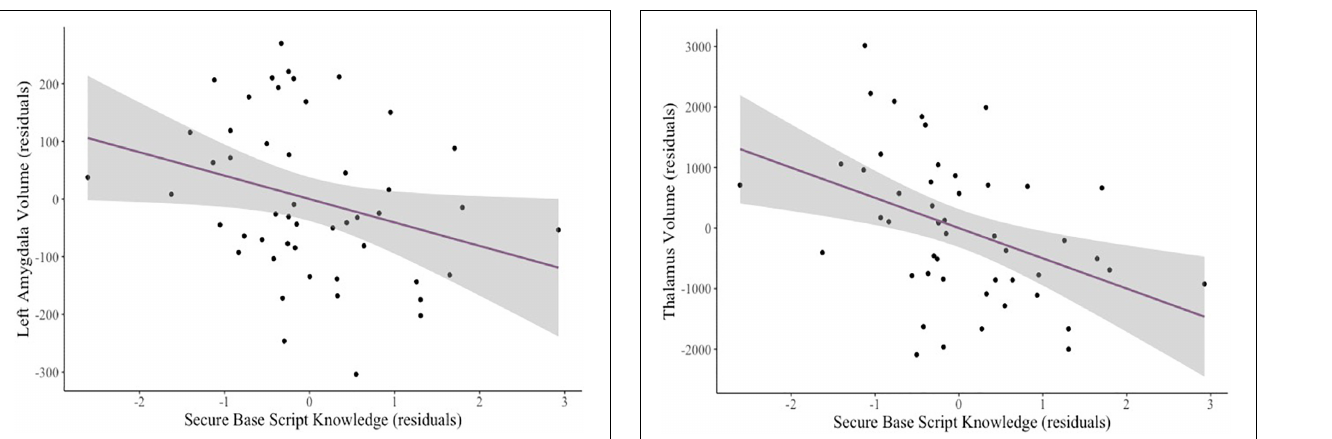
FIGURE 2 | Added variable plot displaying the partial correlation between mothers’ secure base script knowledge and children’s thalamus volume controlling for covariates (sex and age). The shaded region reflects the 95% confidence interval around the regression